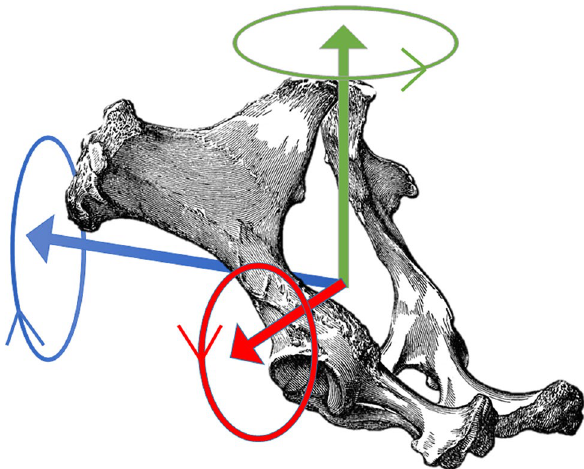
Figure 1. Illustration of pelvic rotations, roll (blue), pitch (red) and yaw (green). Cranial is to the left (blue arrow).